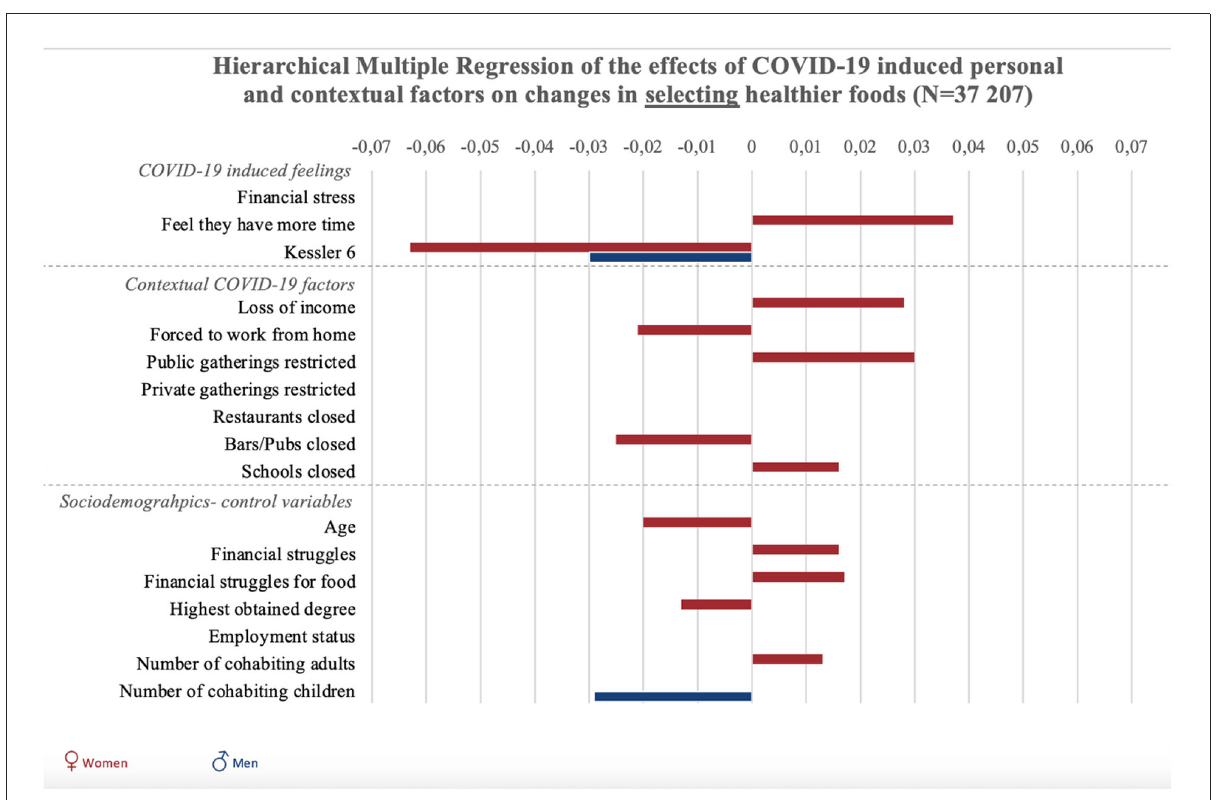
FIGURE2 Graphic summary of the significant relations between personal, contextual and sociodemographic variables and changes in selecting healthier foods during COVID-19. We report beta-values only for significant relations in models 2 for selecting healthier foods. Bars to the right indicate improvement in food selection, bars to the left indicate decreases in selecting healthy